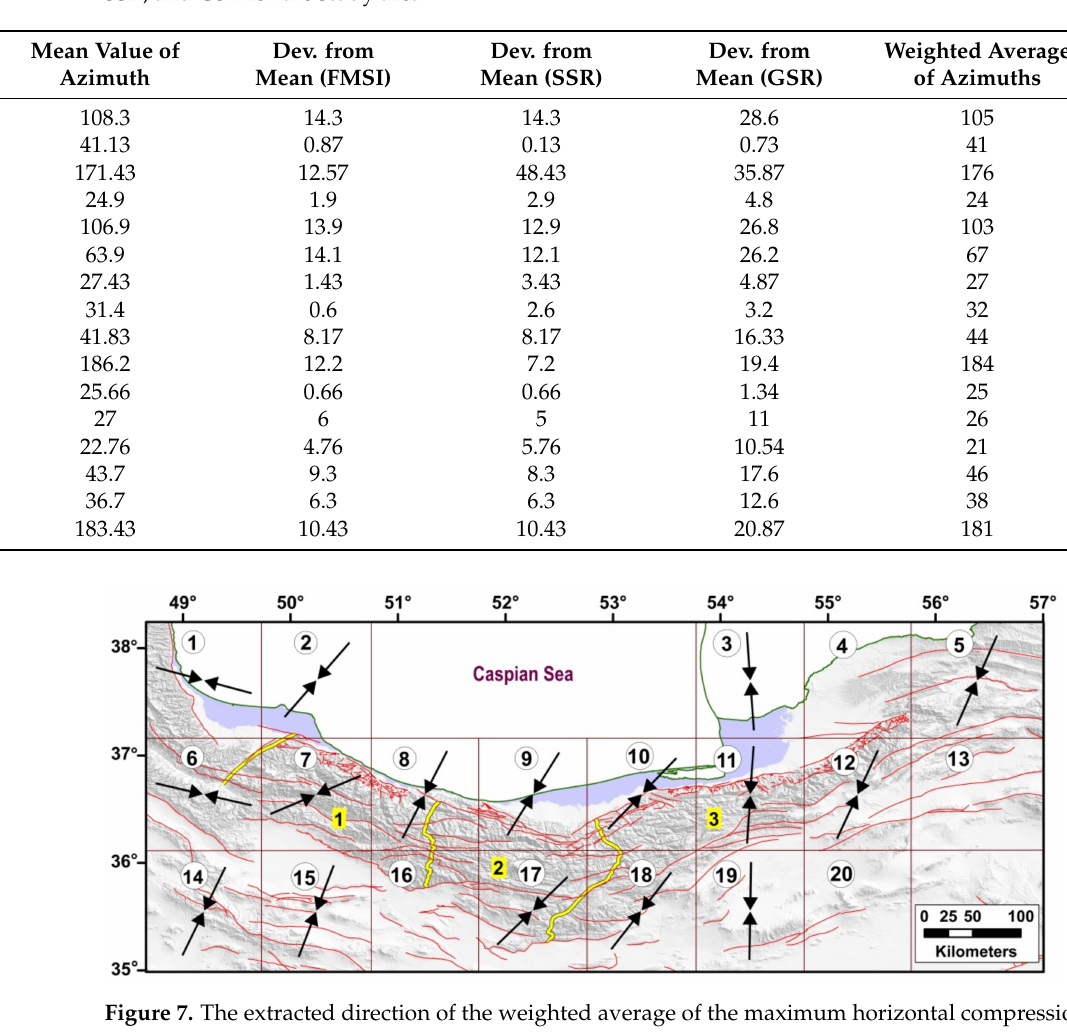
Figure 7. The extracted direction of the weighted average of the maximum horizontal compression stress from GSR, SSR, and FMSI. Labels within grids show grid number. Numbers 1, 2, and 3 are location of the West Alborz, Central Alborz, and East Alborz, respectively which are separated by yellow